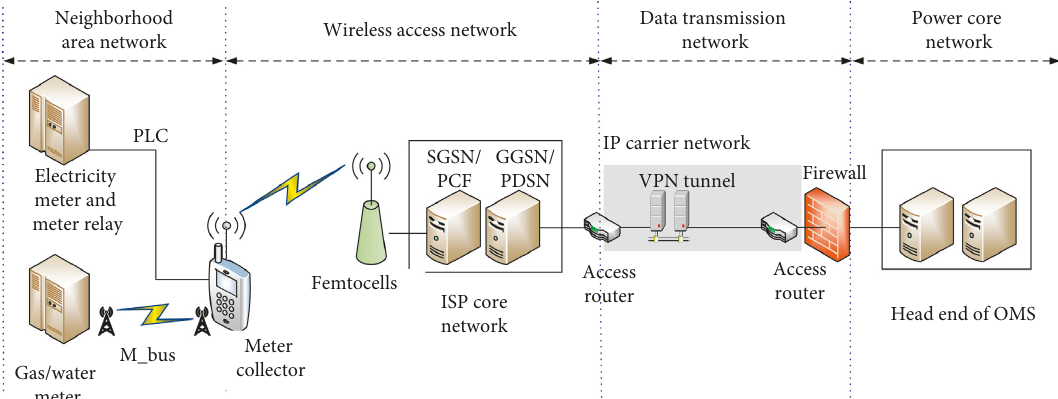
Figure 1: Communication architecture of